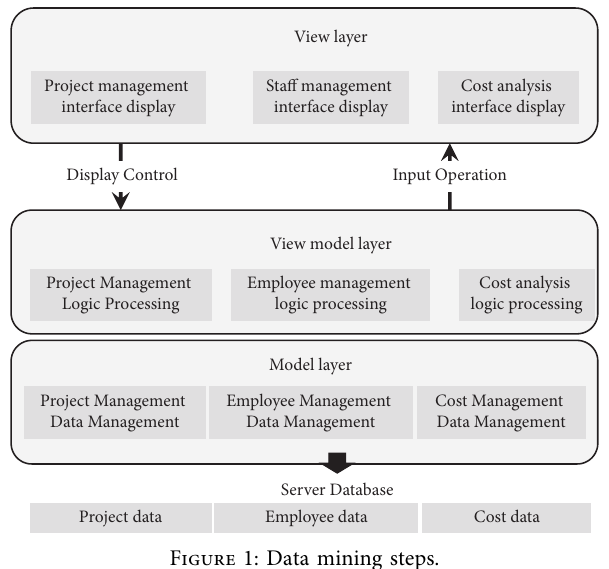
Figure 1: Data mining